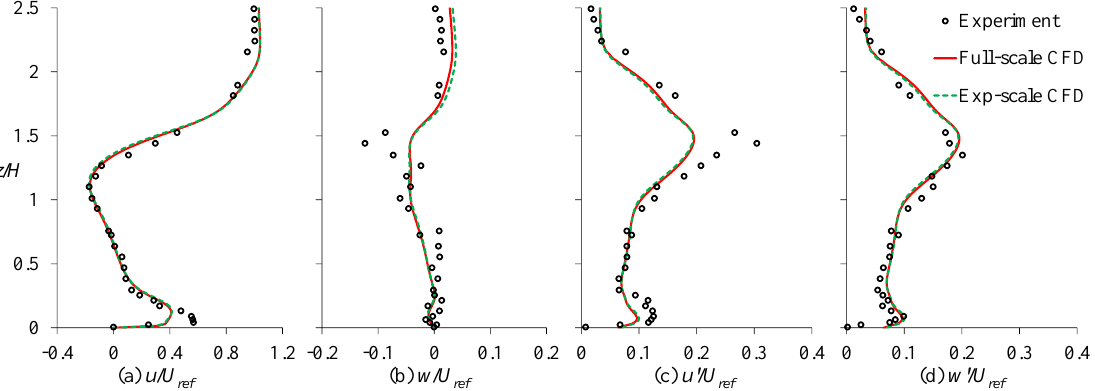
Figure 13. Normalized middle-line velocity profiles at canyon 4 comparing experimental and CFD results for the case with a wind catcher. ( a ) mean stream-wise velocity, ( b ) mean vertical velocity, ( c ) stream-wise velocity fluctuation, and ( d ) vertical velocity fluctuation. “Exp-scale” and “Full-scale” are experimental scale and real scale in a built